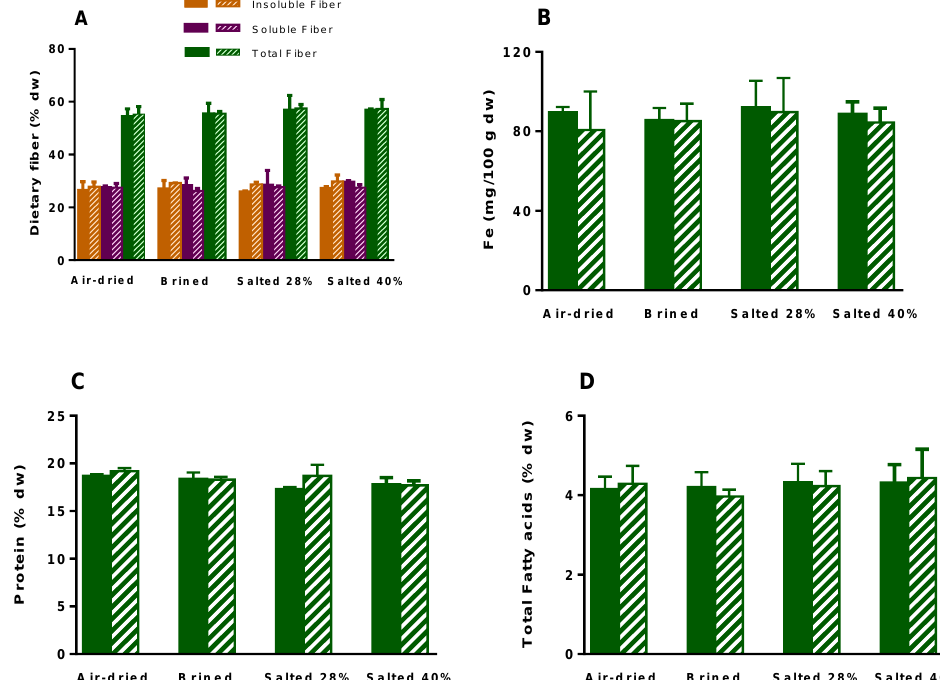
Figure 3. Content of fiber ( A ), iron ( B ), protein, as determined by N x correction factor of 5; ( C ) and total fatty acids ( D ) of Ulva rigida submitted to different preservative processes (air-drying, brining, salting at 28% and 40%), just after the application of treatment (t0, full representations) and after six months of storage (t180, line representations) at room temperature (air-dried) or 4 °C (salt-processed). The results correspond to mean ± standard deviation (n = 3).